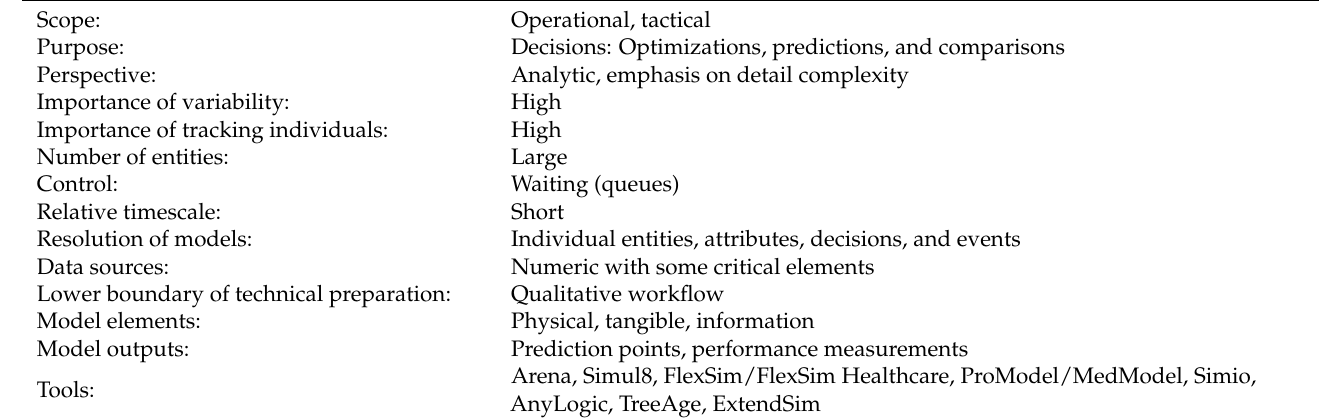
Table 1. Characteristics of discrete event